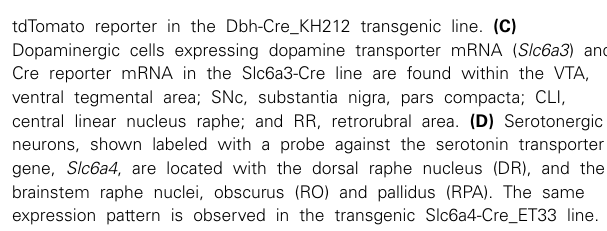
tdTomato reporter in the Dbh-Cre_KH212 transgenic line. (C) Dopaminergic cells expressing dopamine transporter mRNA ( Slc6a3 ) and Cre reporter mRNA in the Slc6a3-Cre line are found within the VTA, ventral tegmental area; SNc, substantia nigra, pars compacta; CLI, central linear nucleus raphe; and RR, retrorubral area. (D) Serotonergic neurons, shown labeled with a probe against the serotonin transporter gene, Slc6a4 , are located with the dorsal raphe nucleus (DR), and the brainstem raphe nuclei, obscurus (RO) and pallidus (RPA). The same expression pattern is observed in the transgenic Slc6a4-Cre_ET33